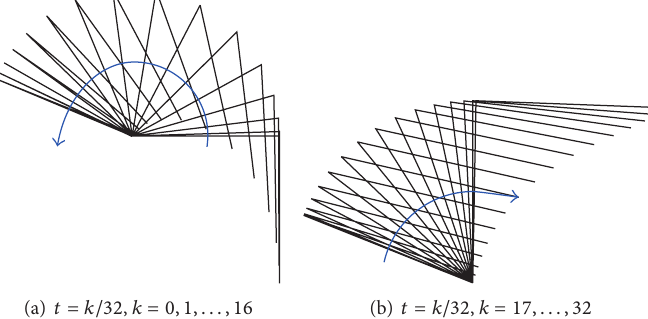
(a) 𝑡 = 𝑘/32 , 𝑘 = 0,1,...,16 (b) 𝑡 = 𝑘/32 , 𝑘 = 17,...,32 Figure 4: Sequence of configurations of the robot manipulator at times 𝑘(1/32) with 𝑘 = 0, 1, .. ., 32 corresponding to the optimal solution of problem 2, an initial value problem for an 𝑅𝑅 robot manipulator with boundary conditions 𝜃 1 (𝑡 𝐼 ) = 0 [ rad ] , 𝜃 2 (𝑡 𝐼 ) = −𝜋/2 [ rad ] , 0 [ rad / s ] , ̇ 𝜃 (𝑡 ) = 0 [ rad / s ] , 𝜃 (𝑡 ) = 𝜋/2 [ rad ] , 𝜃 (𝑡 ) = −𝜋/2 [ rad ] , ̇ 𝜃 (𝑡 ) = free, and ̇ 𝜃 (𝑡 ) = 0[ rad / s ] , obtained with a discretization of 2 𝐼 1 𝐹 2 𝐹 1 𝐹 2 𝐹 , 𝑡 ] into 64 intervals. The initial and final times are 𝑡 = 0 and 𝑡 = 1 [ s ] , respectively. The corresponding control and state variables are [𝑡 𝐼 𝐹 𝐼 𝐹 represented in Figure